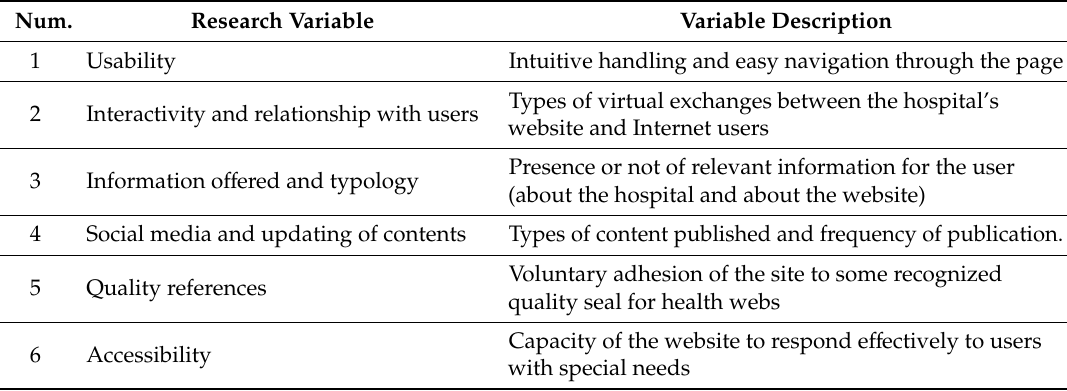
Table 1. Research variables of study and description.